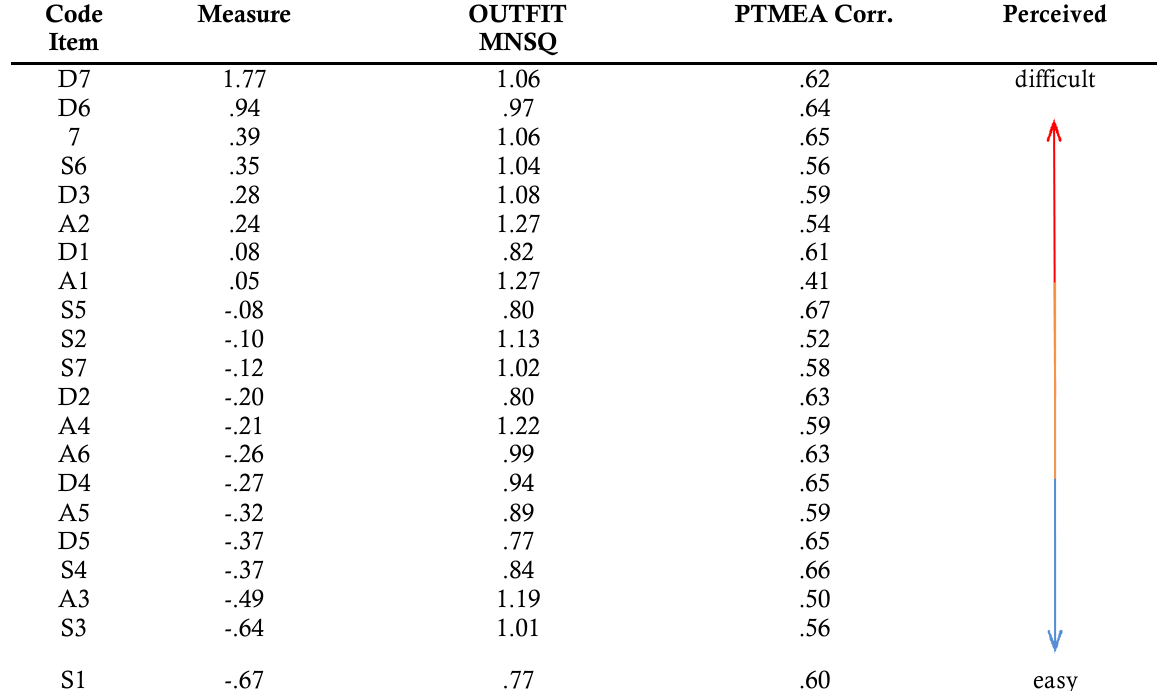
Table 3. DASS Measure Items (Items = 21)